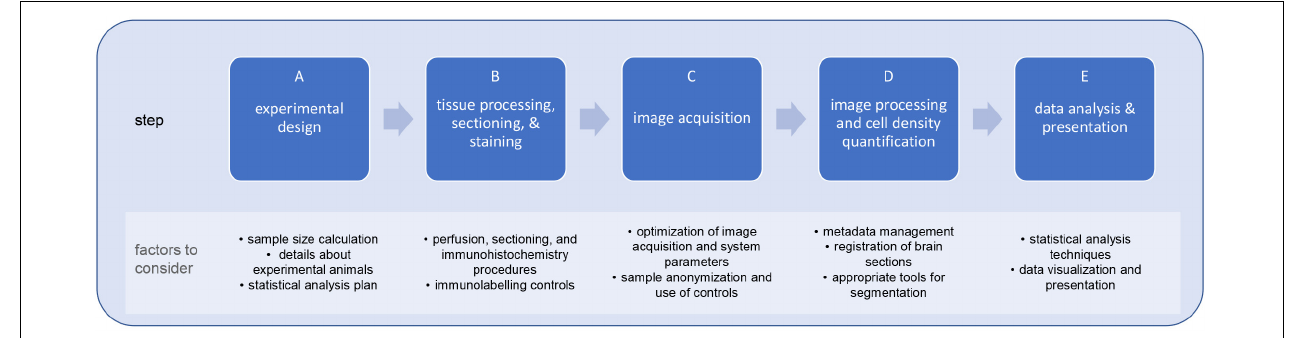
FIGURE 1 | Steps and limiting factors involved in planning and executing a research study on cell-type quantification in brain sections. Research studies for the quantification of cell-types in the mouse brain are sequential multi-step processes (A–E), each with their own limiting factors. By formulating this type of studies within a systematic framework, researchers can mitigate such limiting factors and, consequently, increase the reliability, reproducibility, and usability of study outcomes.